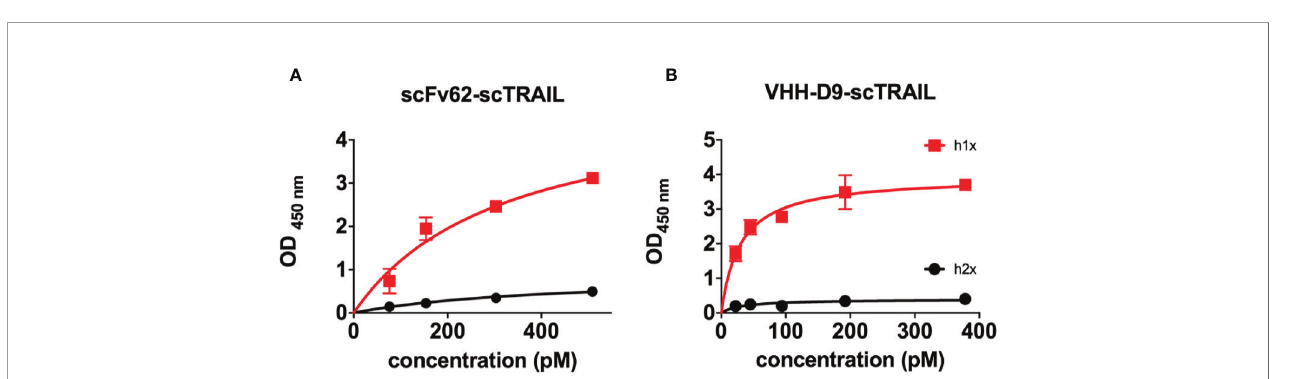
FIGURE 4 | Apparent af fi nity and selectivity of scFv62-scTRAIL and VHH-D9-scTRAIL. h1x and h2x antigens were immobilized on ELISA plates and incubated with different concentrations of the relevant fusion proteins. Binding of the fusion was measured by detection of TRAIL. Results on scFv62-scTRAIL are shown in (A) , and those of VHH-D9-scTRAIL in panel (B) . Black line and symbols correspond to h2x, which produced weak signals in both cases. Red color indicates data obtained with h1x. Error bars indicate standard